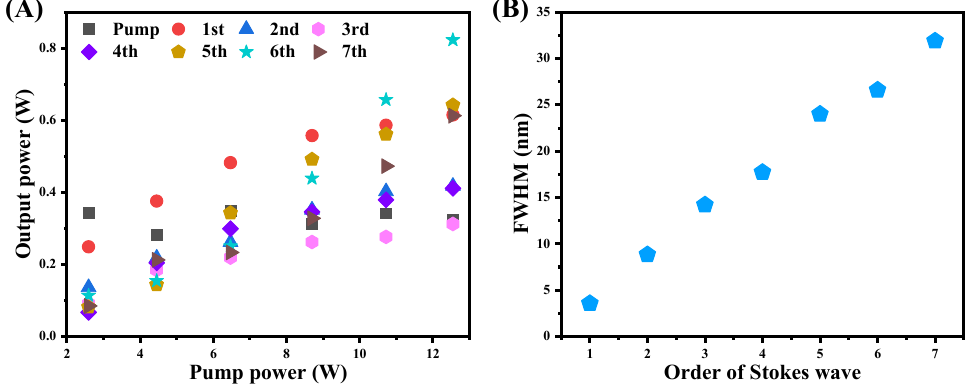
Figure 3. ( A ) Output power of different Stokes waves; ( B ) FWHM of different Stokes waves.